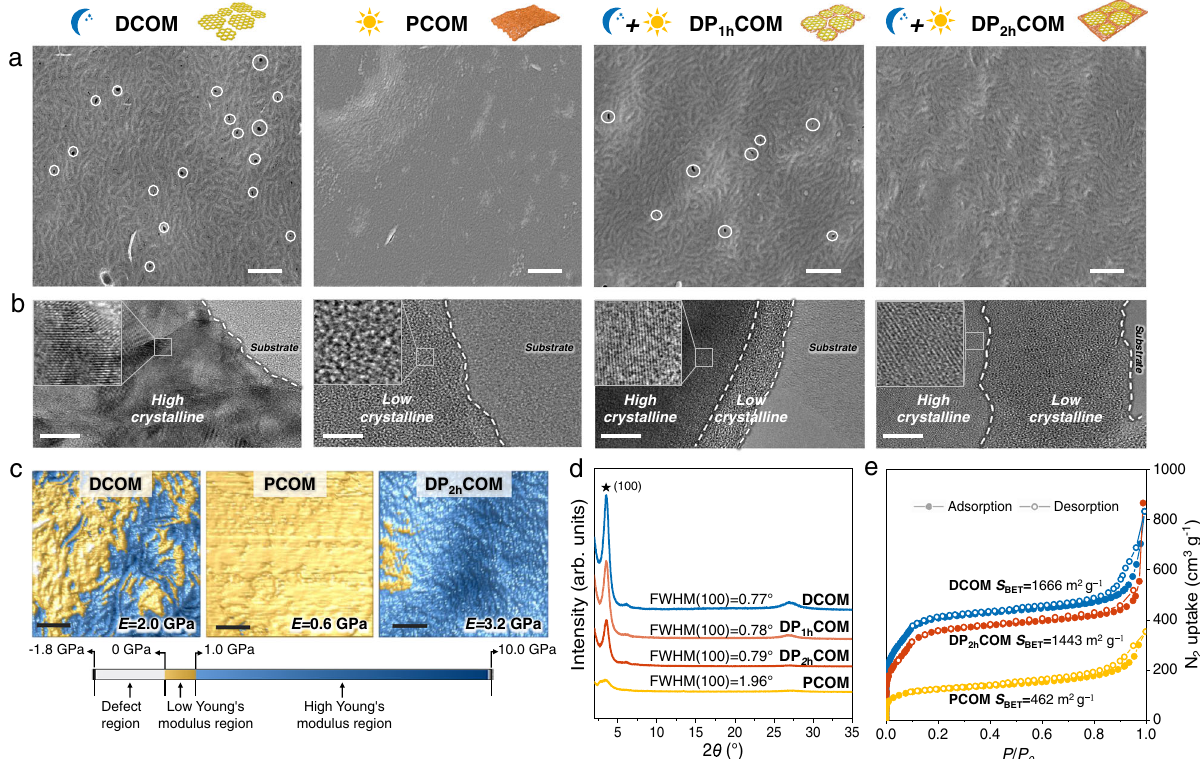
Fig. 3 Structure and morphology characterizations. a Top-view SEM images of COMs deposited on track-etched substrate membranes. The intercrystalline defects are marked by the white circle. Scale bar = 500 nm. b TEM images of the COMs. Insets are high-magni fi cation images where the high-crystalline regions show lattice diffraction patterns. Scale bar = 10 nm. c Young ’ s moduli of COMs tested using the peak force quantitative nano- mechanical property mapping method. Scale bar = 200 nm. d , e XRD patterns ( d ) and N 2 adsorption isotherms ( e ) of DCOM (blue), DPCOMs (red), and PCOM (yellow). The PCOM here is fabricated under 9.0-mW cm − 2